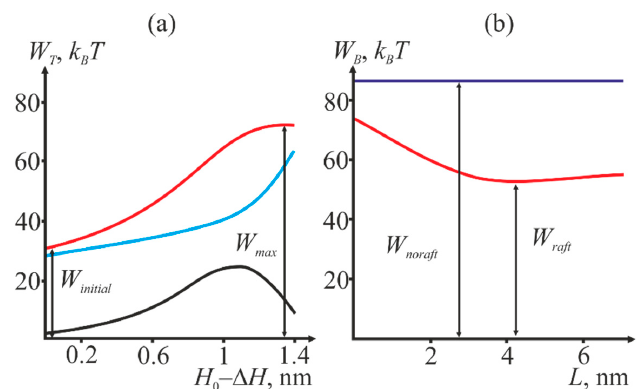
Figure 4. ( a ) Dependence of the system total energy W T (shown in red) on the reaction coordinate H 0 − Δ H . The blue curve is the deformation energy of the two membranes, the black one is the energy of hydration repulsion of the membranes and hydrophobic interaction of the defects. The graph corresponds to the values of R = 3 nm, L = 3 nm, H 0 = 3 nm. ( b ) Dependence of the energy barrier W B to stalk formation on the width L of the raft transient zone (shown in red). The energy barrier in the absence of raft in the target cell membrane is shown in blue. The graph corresponds to the values of R = 3 nm, H 0 = 4 nm. For each fixed H 0 , the energy barrier is minimized against the transient zone width L . This corresponds to the minimum of the red curve in Figure 4b (designated as W raft ). Then, we compare the obtained value with the barrier height in the absence of the raft (designated as W noraft ). Two values: the minimal height of the barrier W raft and difference Δ W are of crucial importance for our analysis.